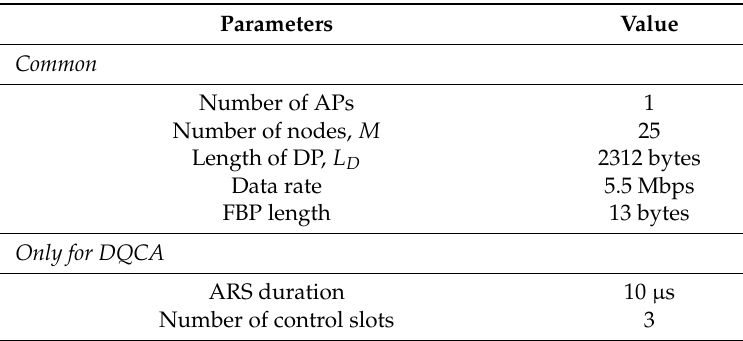
Table 2. System parameters (© 2016